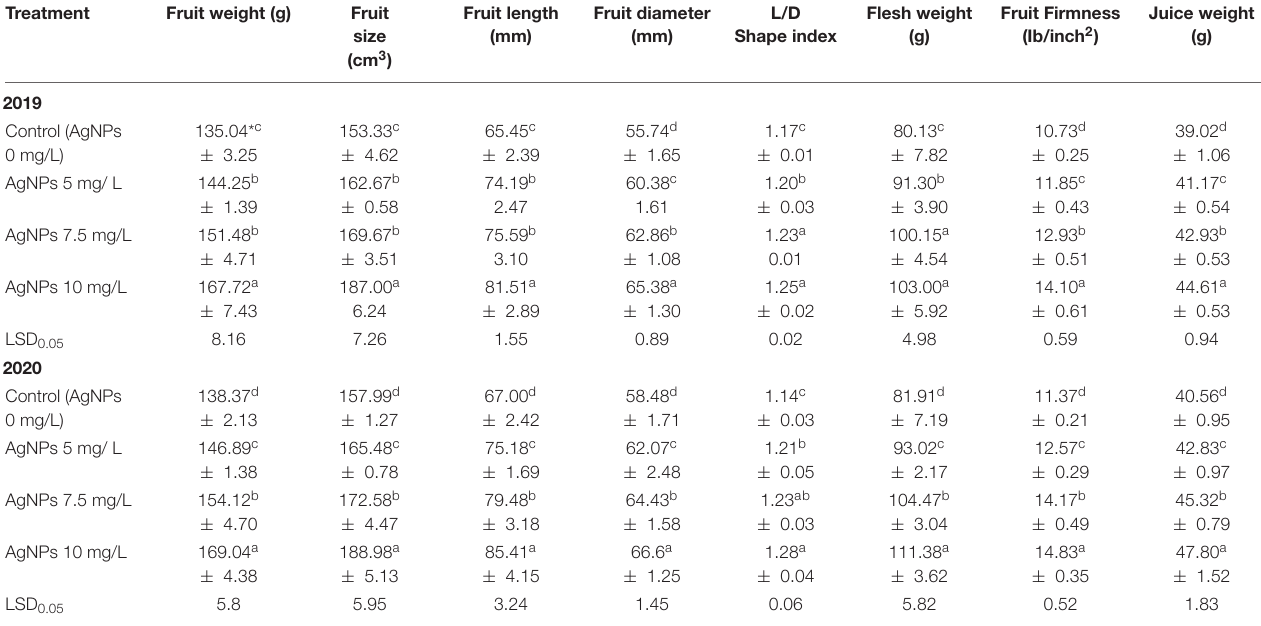
TABLE 3 | Influence of AgNPs spraying on “Eureka” lemon fruit weight, size, length and diameter, shape index, flesh weight, fruit firmness, and fruit juice weight during 2019 and 2020 seasons. Treatment Fruit weight